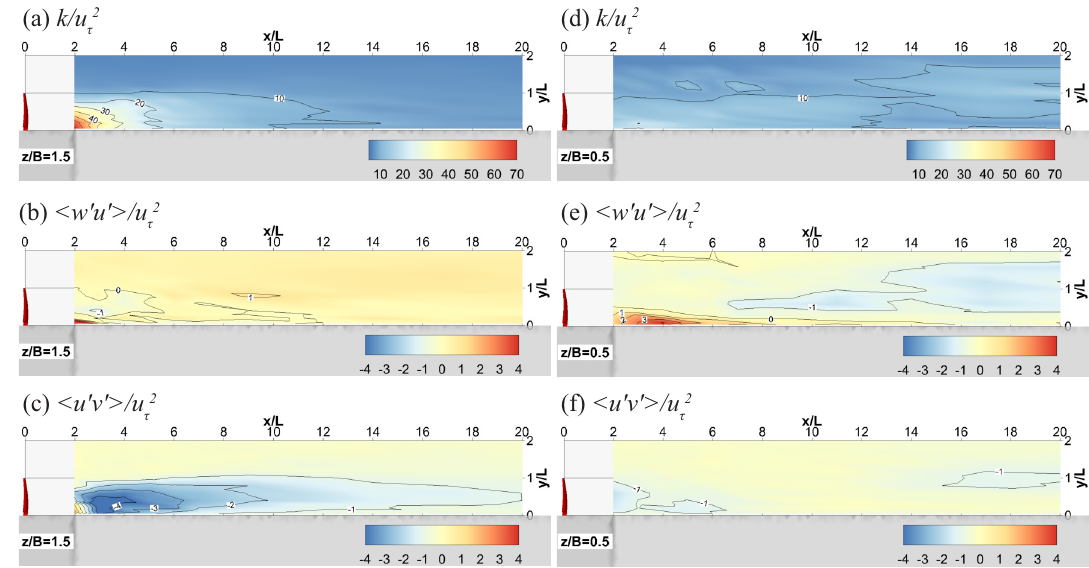
Figure 9. Dimensionless turbulence characteristics contours at z / B = 1.5 ( blade center height, ( a – c )) and z / B = 0.5 (the midpoint between the bottom edge of the blade and the channel bed, ( d – f